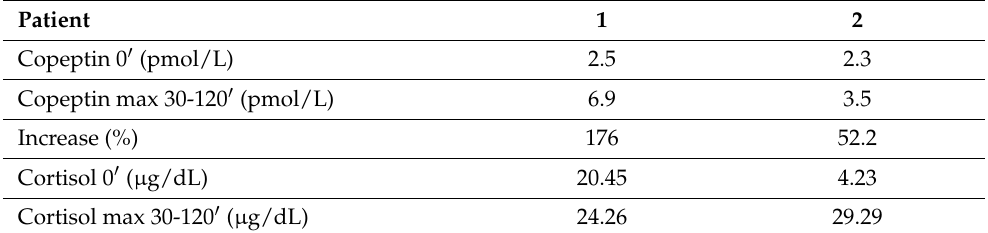
Table 3. Both subjects had diagnostic ITT, as reflected by a fall in glucose below 2.2 mmol/L (40 mg/dL). The relative increase in copeptin concentrations during ITT (176% and 52.2%) overlapped with the individual increments observed during GST; however, in contrast to GST, there was an increase in cortisol secretion in comparison to the initial levels (from 20.45 µ g/dL to 24.26 µ g/dL and from 4.23 to 29.29 µ g/dL, respectively). Similarly to the GST group, GH secretion was also significantly stimulated. Table 3. Copeptin, cortisol and GH levels in the two patients during ITT-basal and maximal values observed 30–120 min after insulin administration plus concentration relative change